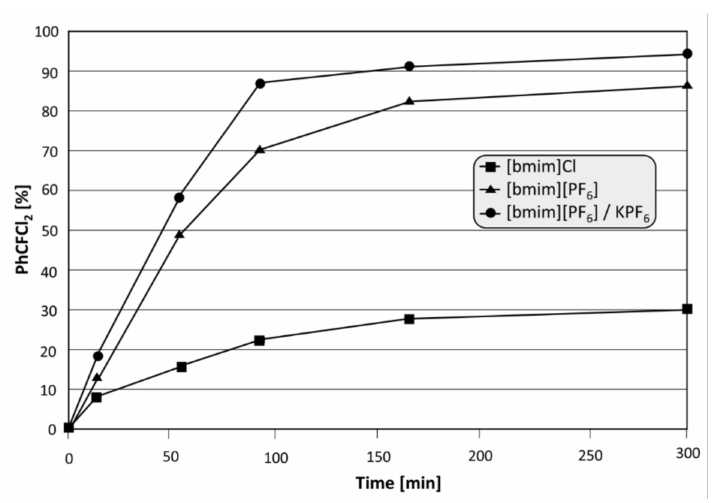
Figure 1. Fluorination by KF in ILs [28].